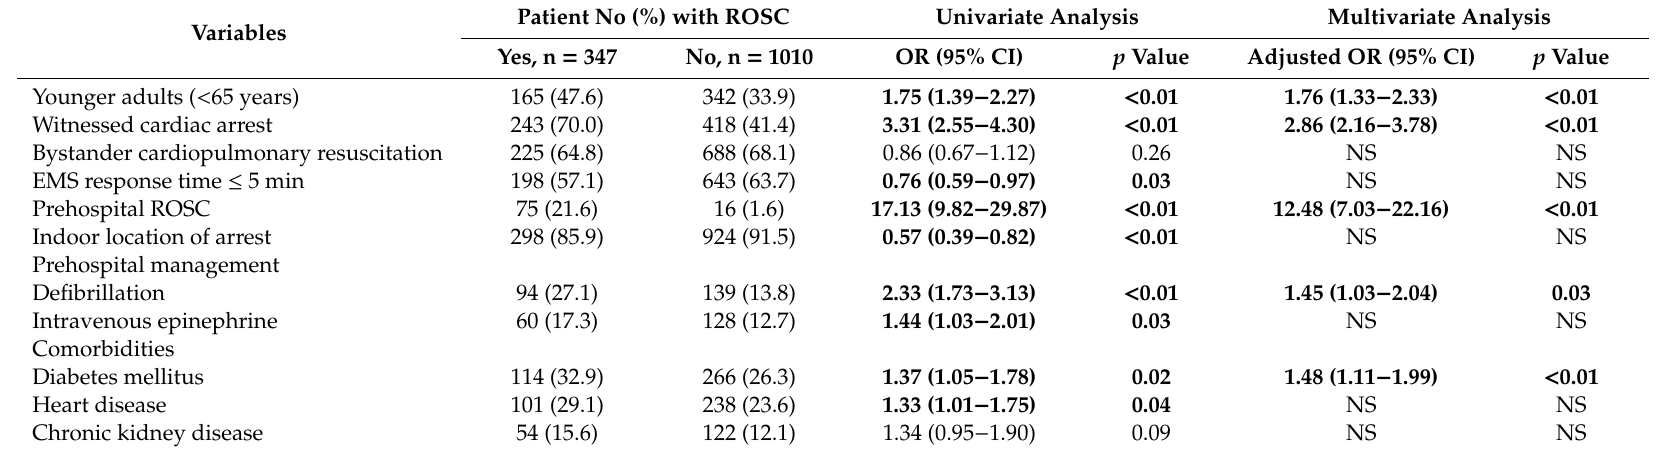
Table 2. Predictors of achievement of a sustained ( ≥ 2 h) return of spontaneous circulation.